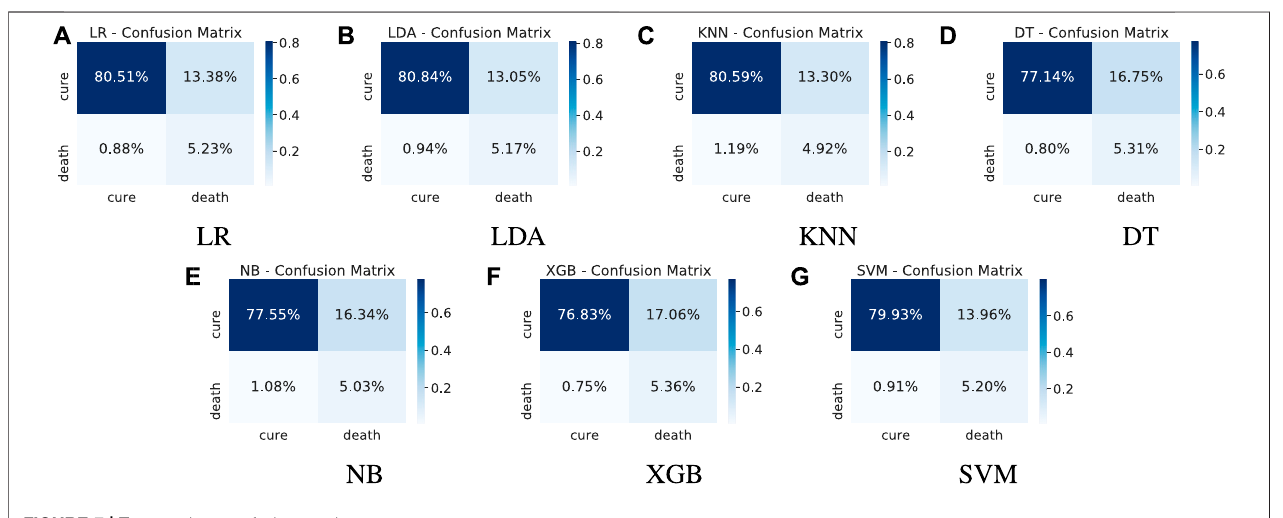
FIGURE 7 | Test results - confusion matrices.